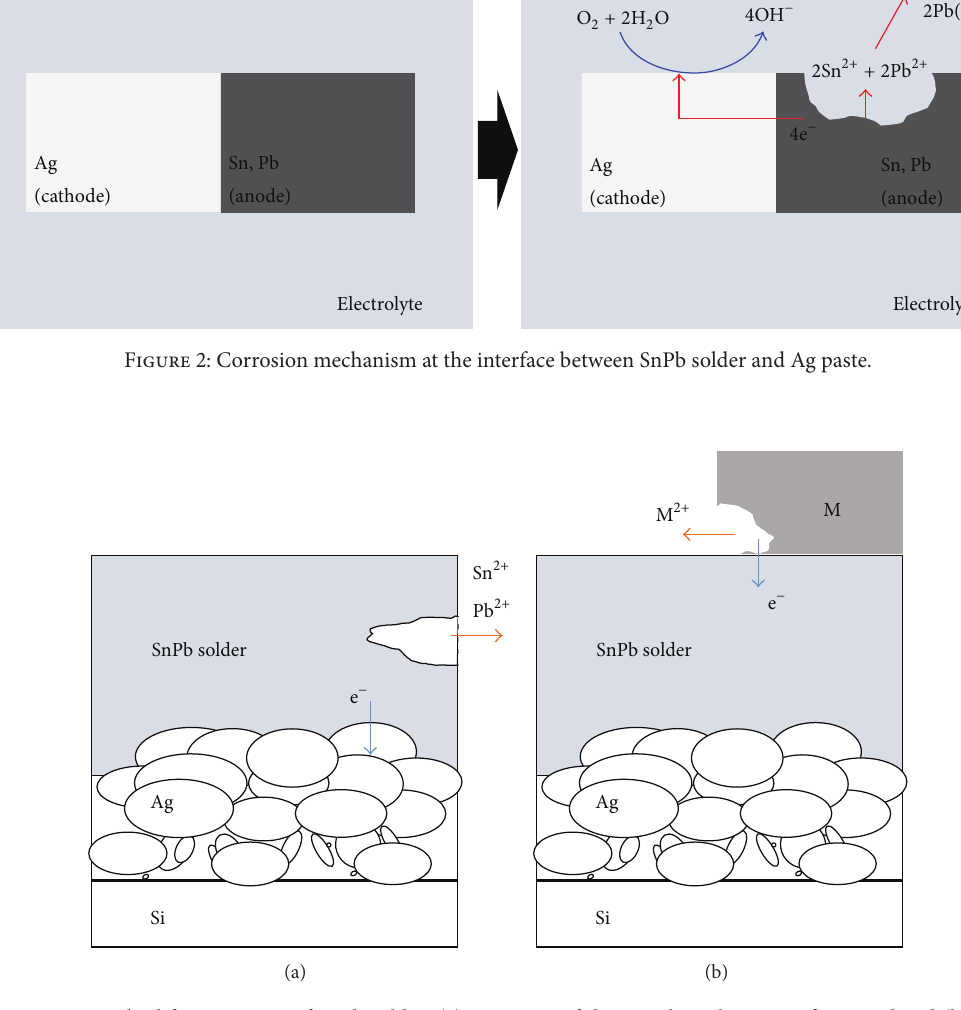
Figure 3: A mitigation method for corrosion of SnPb solder: (a) corrosion of the sample without sacrifice metal and (b) corrosion of the sample with a sacrificial metal anode (Zn or